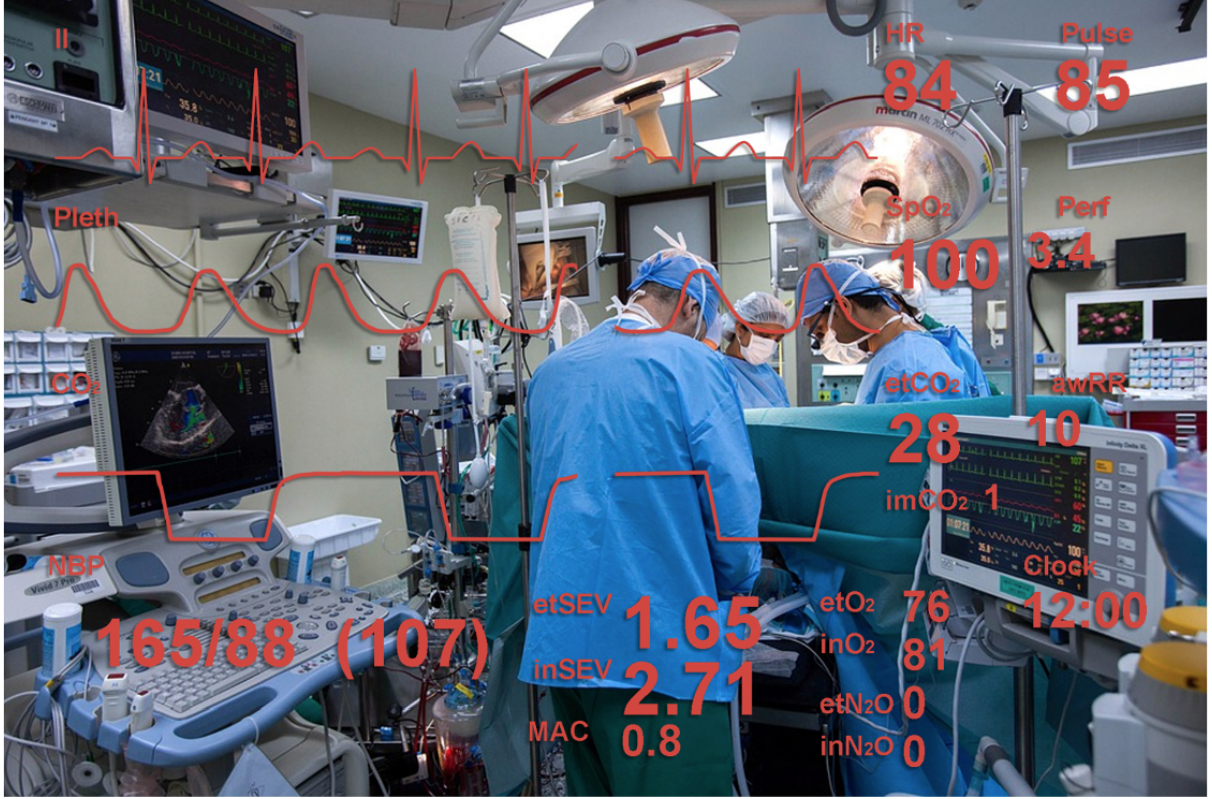
respiratory rate; CO 2 : carbon dioxide; EtCO 2 : end-tidal carbon dioxide partial pressure; etN 2 O: end-tidal nitrous oxide concentration; etSEV: end-tidal sevoflurane concentration; HR: heart rate; imCO 2 : inspired minimum CO 2 ; inN 2 O: inspired nitrous oxide concentration; inSEV: inspired